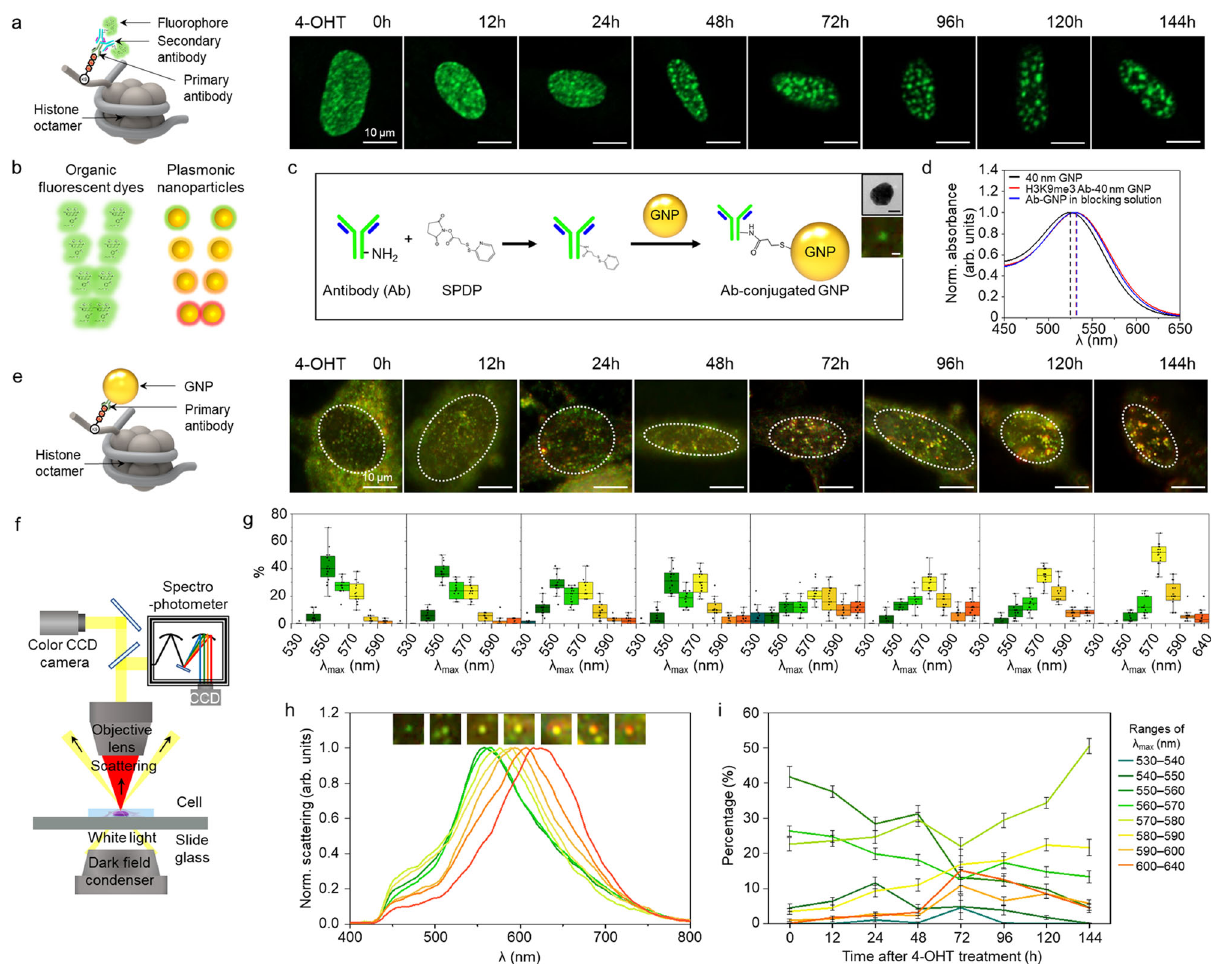
Fig. 2 Single histone marker (H3K9me3) imaging in OIS cells. a Representative fl uorescent image at each OIS time point using organic fl uorophore conjugated with secondary antibody. Images, representing fi ve experiments. Scale bar, 10 µ m. b Comparison of the colors expressed by organic fl uorophore and plasmonic nanoparticles according to the change in distance. c Conjugation strategy of primary antibody to 40 nm gold nanoparticle for preparing a plasmonic nanoprobe (Ab-GNP) with succinimidyl 6-[3 ′ -(2-pyridyldithio)-propionamido] hexanoate (SPDP) linker. Images, representing fi ve experiments. Black scale bar, 20 nm. White scale bar, 500 nm. d Change in absorbance before and after antibody conjugation to the gold nanoparticles. e Representative dark- fi eld scattering images at each OIS time point. Images, representing fi ve experiments. Scale bar, 10 µ m. f Dark- fi eld microscope setup for scattering imaging and spectral analysis of the plasmonic nanoprobes targeting histone marker. g λ max distributions of the spectra of scattering spots ( n = 50) in single cells ( n = 15 cells examined over fi ve independent experiments) during OIS. Box plots indicate median (middle line), mean ( □ ), 25th, 75th percentile (box), and range within 1.5 interquartile range (IQR, whiskers) as well as each data point ( ● ). h Changes in colors (inset) and spectra of the scattering spots induced by the targeted assembly of the probes. i Time-lapse measurement of the maximum scattering wavelength ( λ max ) for the plasmonic nanoprobes in the nuclei after 4-OHT treatment ( n = 15 cells examined over fi ve independent experiments). Data are represented as mean ±